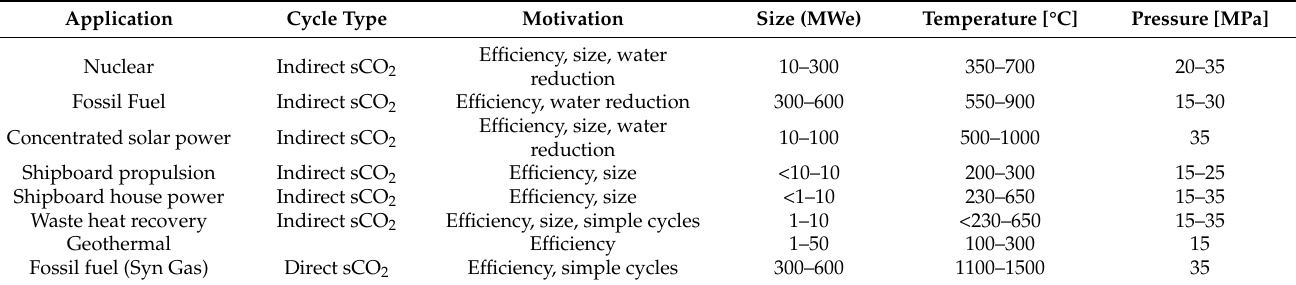
Table 1. Potential application of sCO 2 -BC